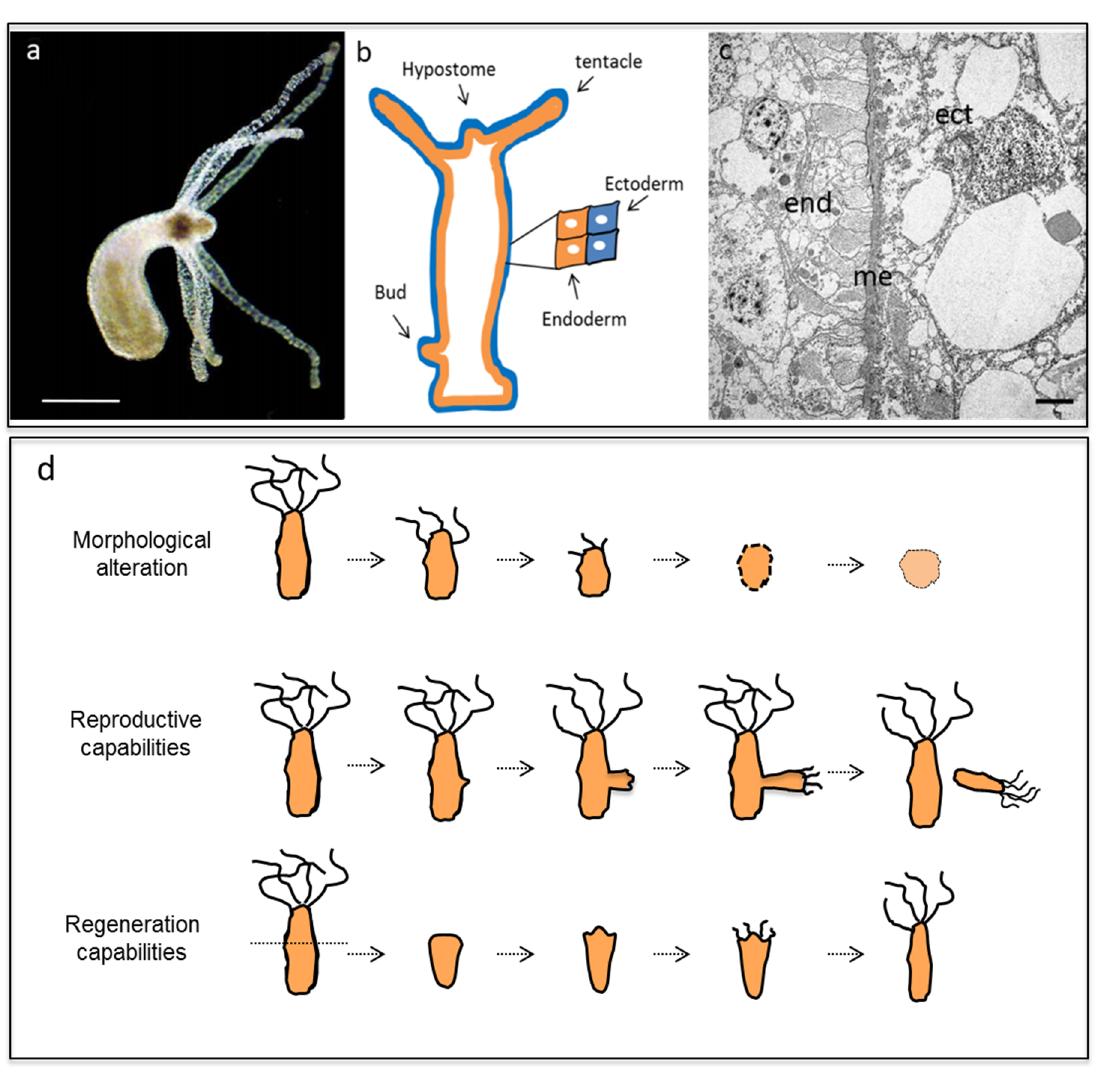
Figure 1. Structural anatomy of Hydra vulgaris . ( a ) The Hydra polyp is structured as a single hollow and transparent tube with a foot responsible for the anchoring to a substrate and a mouth surrounded by a crown of 6–8 tentacles. Scale bar, 500 µm. ( b ) Schematic representation of Hydra tissue organization with the inner endoderm (end) and an outer ectoderm (ect) separated by an acellular matrix, the mesoglea (me). The same structure is shown by transmission electron microscopy ( c ) of tissue cross sections. Scale bar, 10 µm. (d ) Developmental potential of Hydra